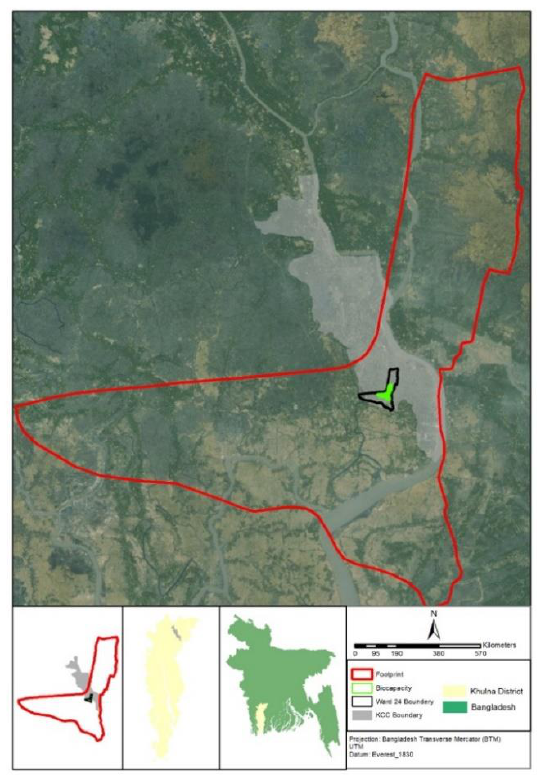
Figure 16. Environmental Stress Visualization.